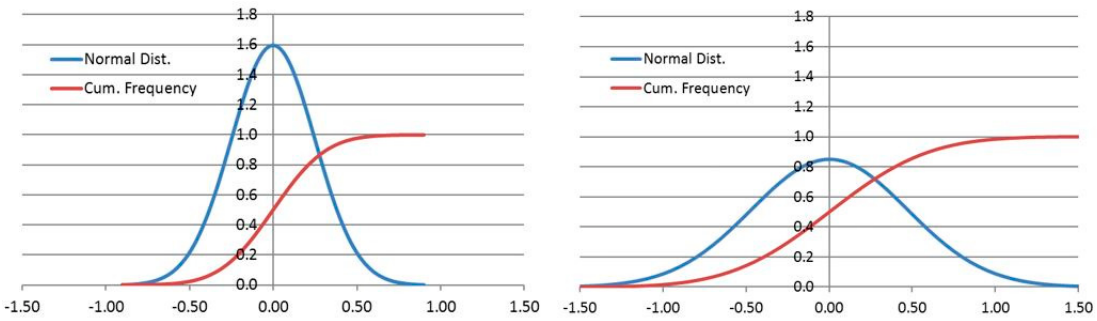
Figure 6. Centered normal distribution and cumulative frequency of the 2050 ( left ) and 2100 ( right ) extreme flood levels (EFLs), corresponding to 12 and 40 cm of standard deviation, respectively.